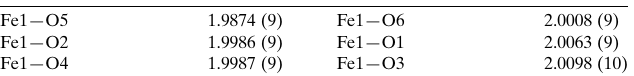
Selected bond lengths (A˚ ).